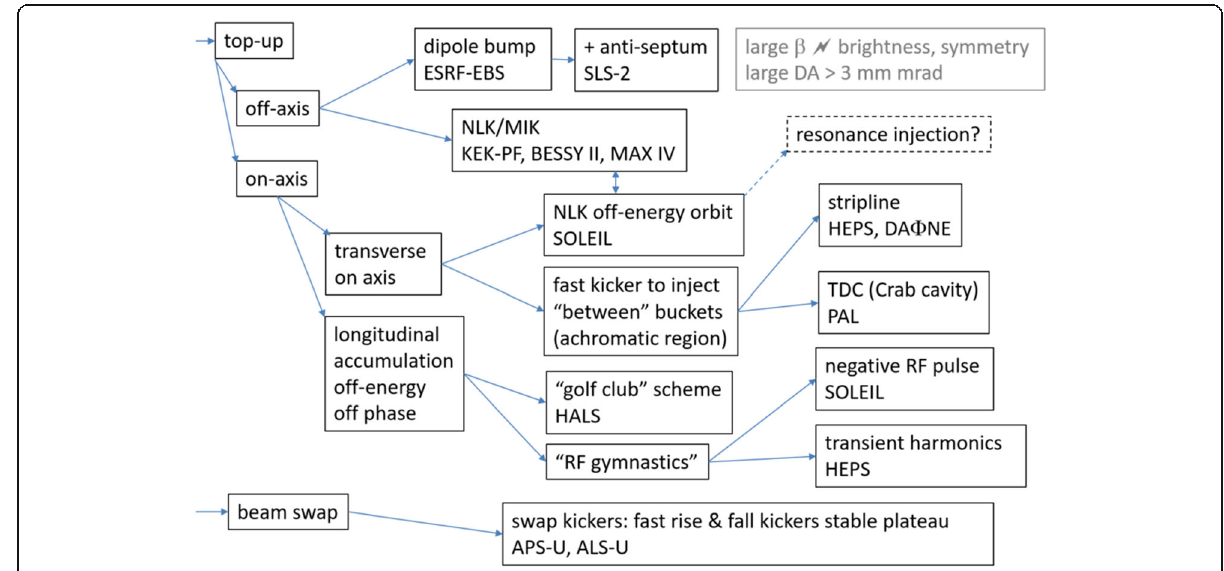
Fig. 20 Summary of injection scheme for 4GSR